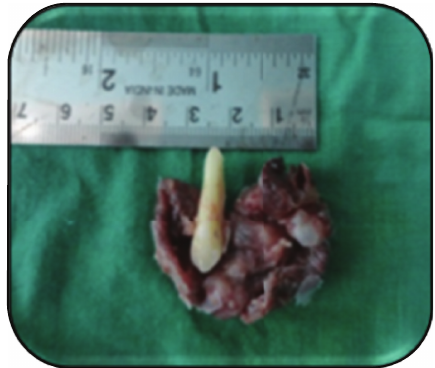
Figure 9: Intraoperative